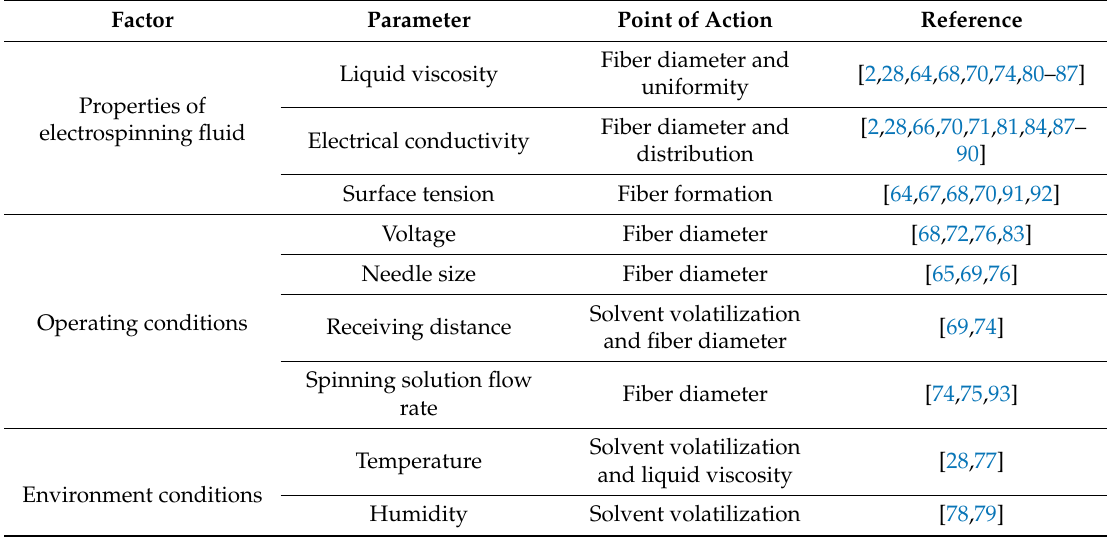
Table 1. Three main factors a ff ecting electrospun sustainable fiber